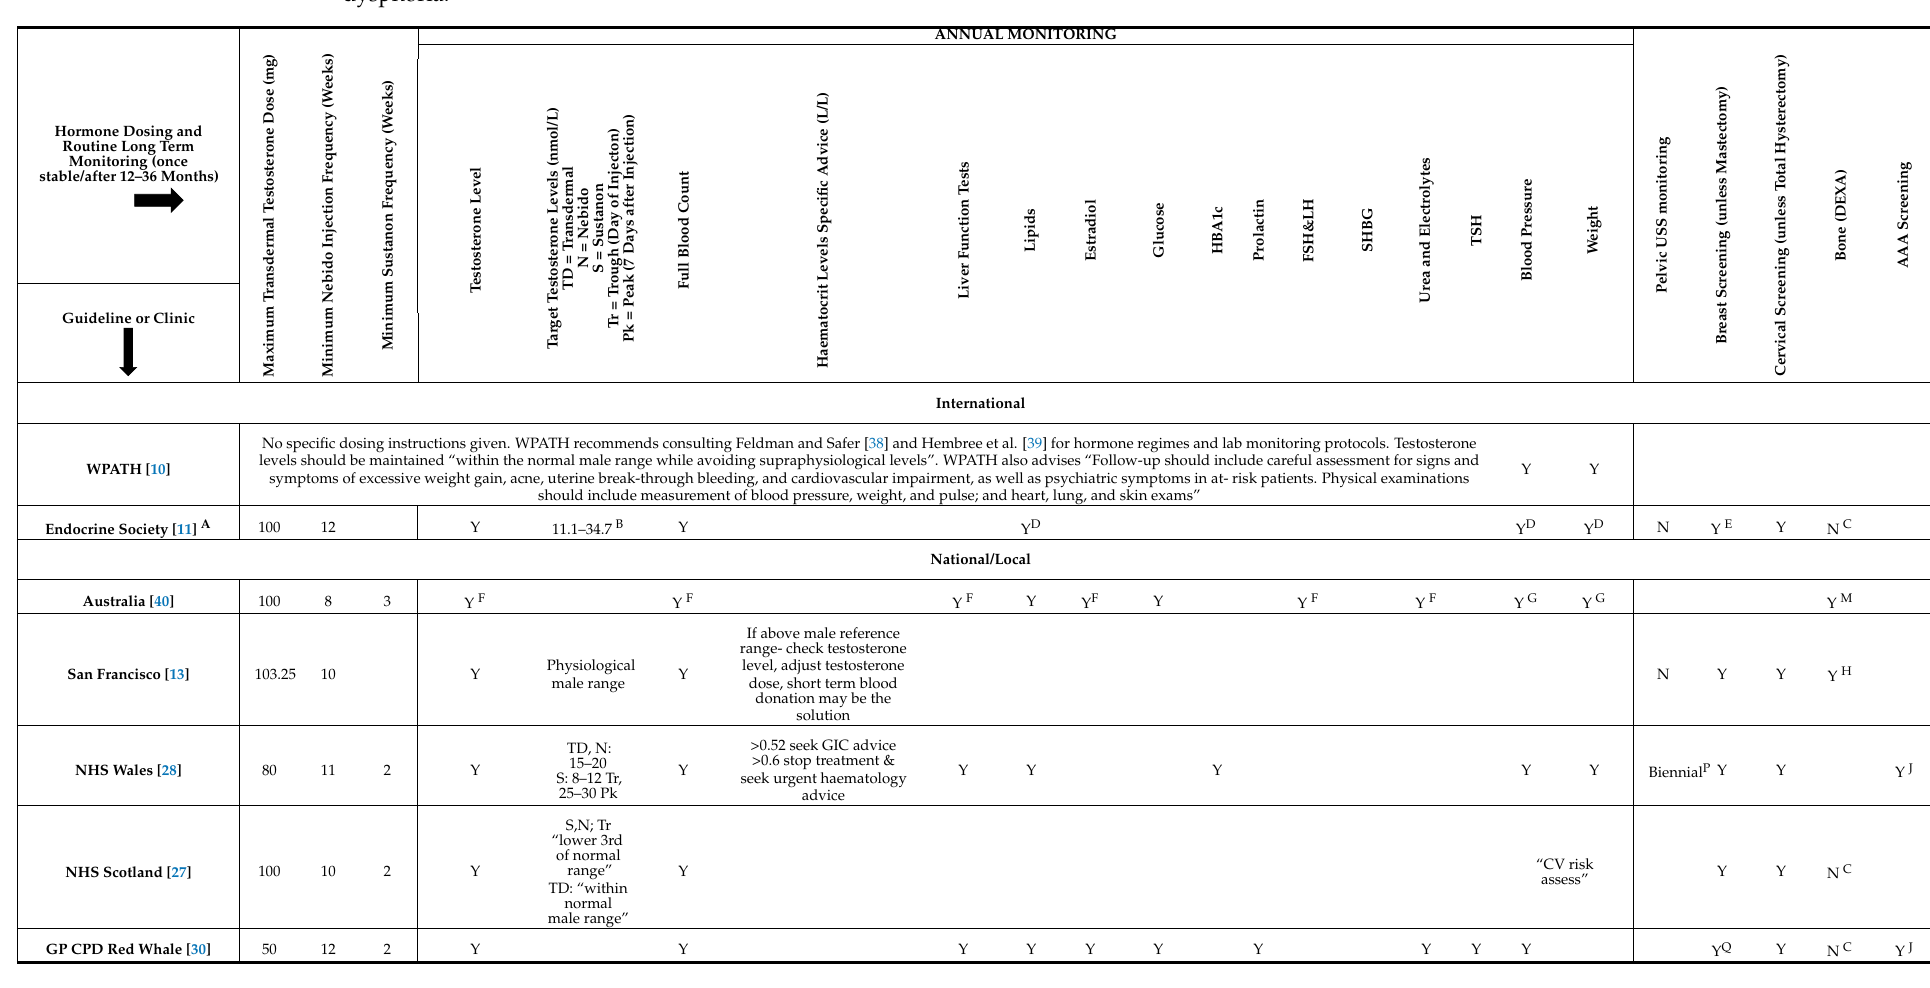
Table 2. Comparison of national, international, and patient specific prescribing and monitoring guidelines for trans women (observed males at birth) with gender dysphoria.